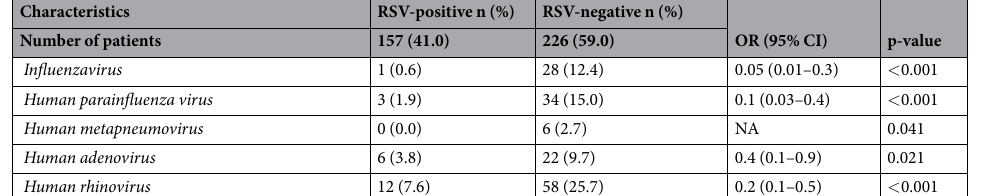
Table 2. Characteristics of ARI patients positive for RSV in comparison to ARI patients negative for RSV. Data in the table are number of patients and percentages, except for a few variables for which the unit is specified. Because of missing values, superscript numbers indicate the number of patients for whom data were available. Low birth weight: defined by World Health Organisation as weight at birth less than 2,500 g 31 . Fever: defined as body temperature ≥ 38 °C per axilla 32 . Children less than 2 years old were defined as ‘PCV13 received’ if they had received: at least two doses of vaccine for children less than 1 year old or at least one dose of vaccine for children between 1 to 2 years old. Wet season: from May to